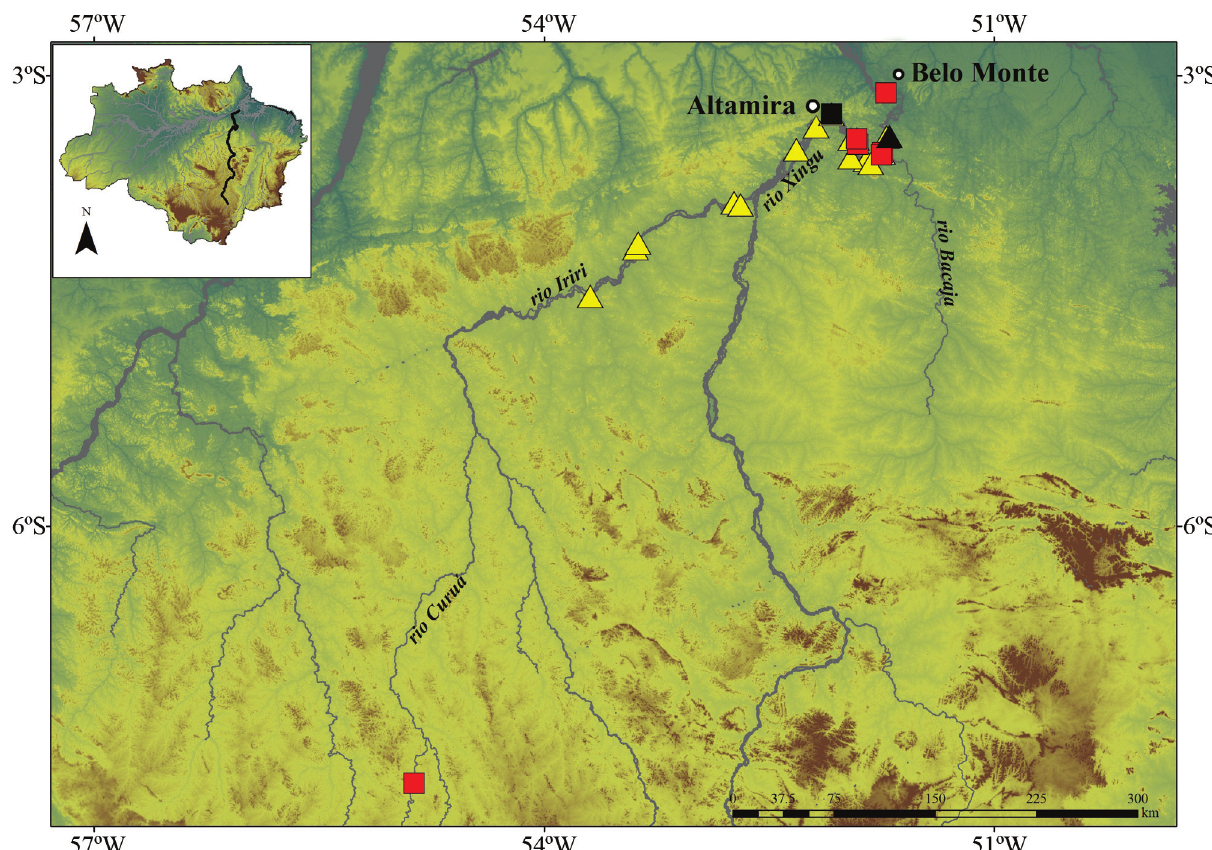
Fig. 3. Map of lower rio Xingu area, showing the collecting sites of Baryancistrus xanthellus (triangles) and Baryancistrus chrysolomus (squares). Black solid symbols indicate holotypes